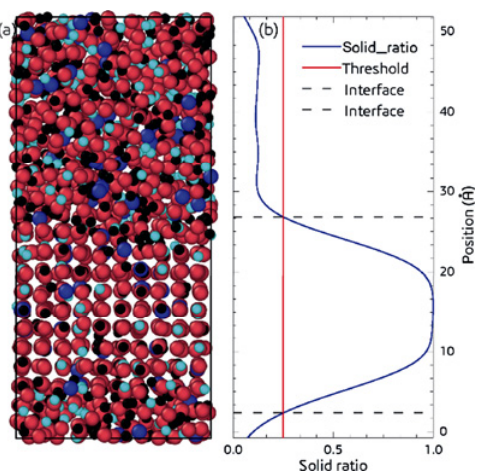
Fig. 2 Comparison of equations of states of rock-salt-structure HfC, HfN, TaC, and TaN predicted by the DP model with DFT calculations.